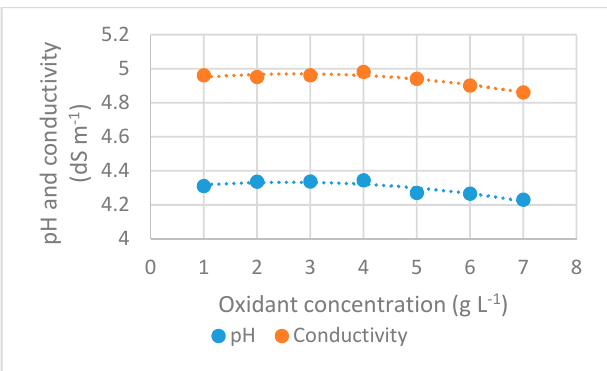
Figure 7. Effect of hydrogen peroxide oxidation on the pH and